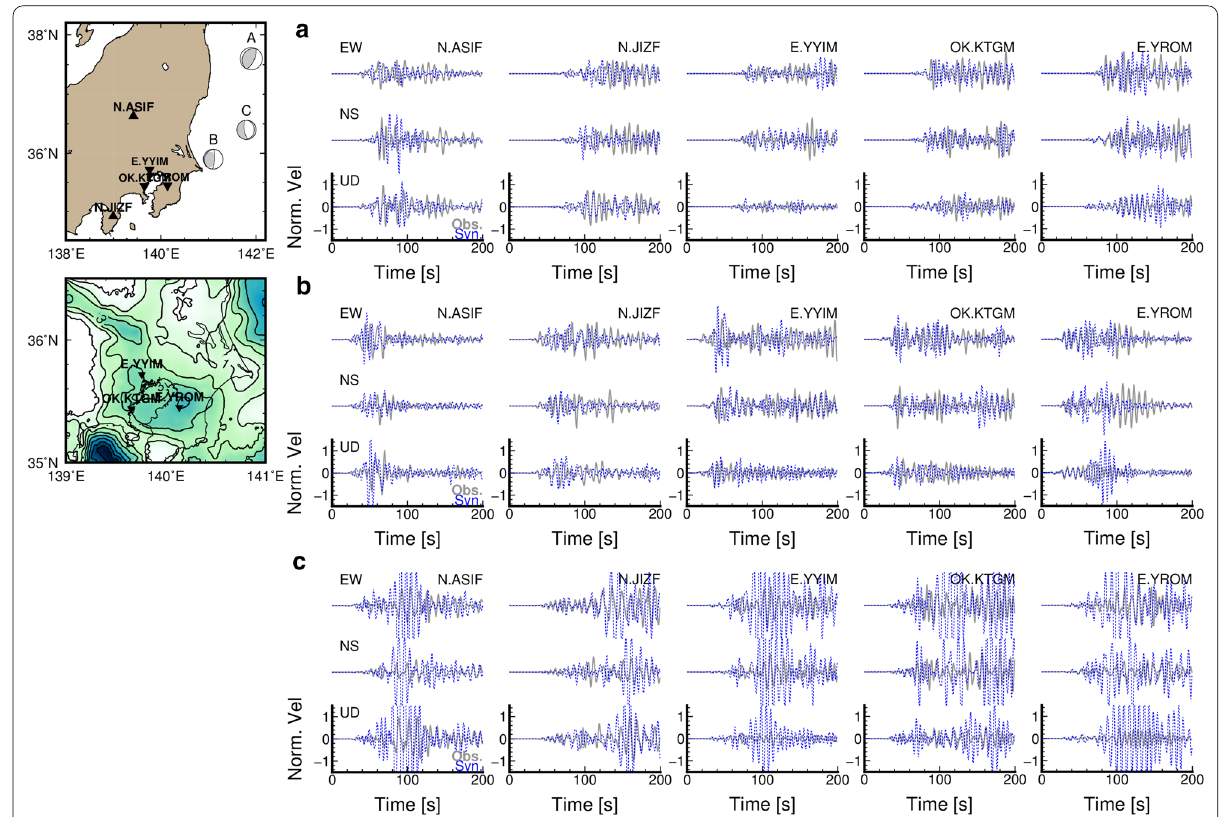
Fig. 12 Comparisons between observed and simulated seismograms for periods of 5–16 s. We selected two F-net (N.ASIF and N.JIZF) and three MeSO-net (E.YYIM, OK.KTGM, and E.YROM) stations. Amplitudes at each station were normalized by the maximum amplitudes of observed seismograms for periods of 5-16 s at each station. a Event A, b Event B, and c Event C. Gray and blue dotted lines are the observed and simulated seismograms, respectively. Left panels show used stations and bedrock depths of the JIVSM. Color for bedrock depths is similar as Fig.